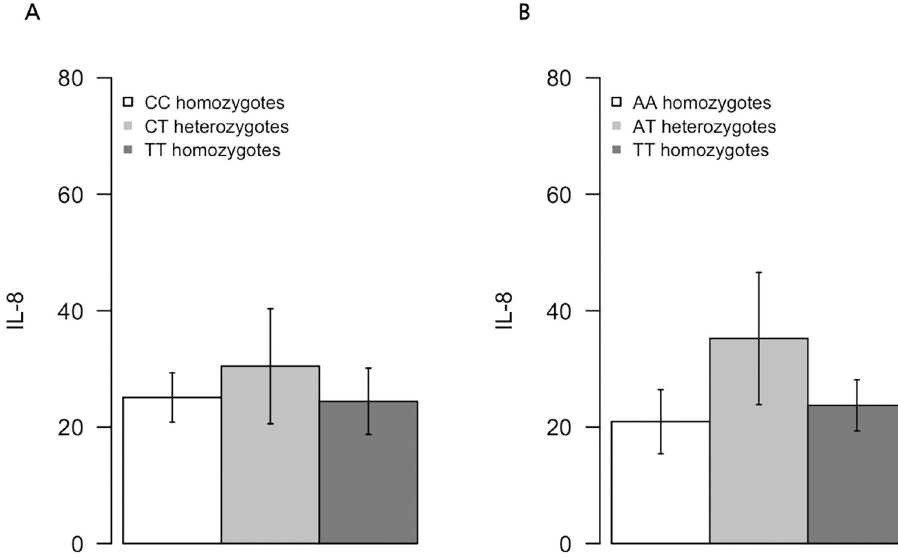
Fig 3. Serum IL-8 level according to genotyping of IL-8. (A) allele -251 (B) allele -781.